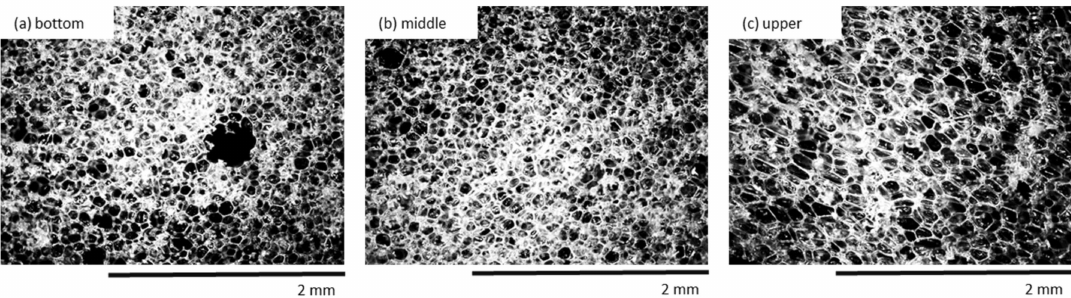
Figure 9. The cellular structure of the ( a ) bottom, ( b ) middle, and ( c ) upper parts of PU-1 observed at a magnification of 50 ×